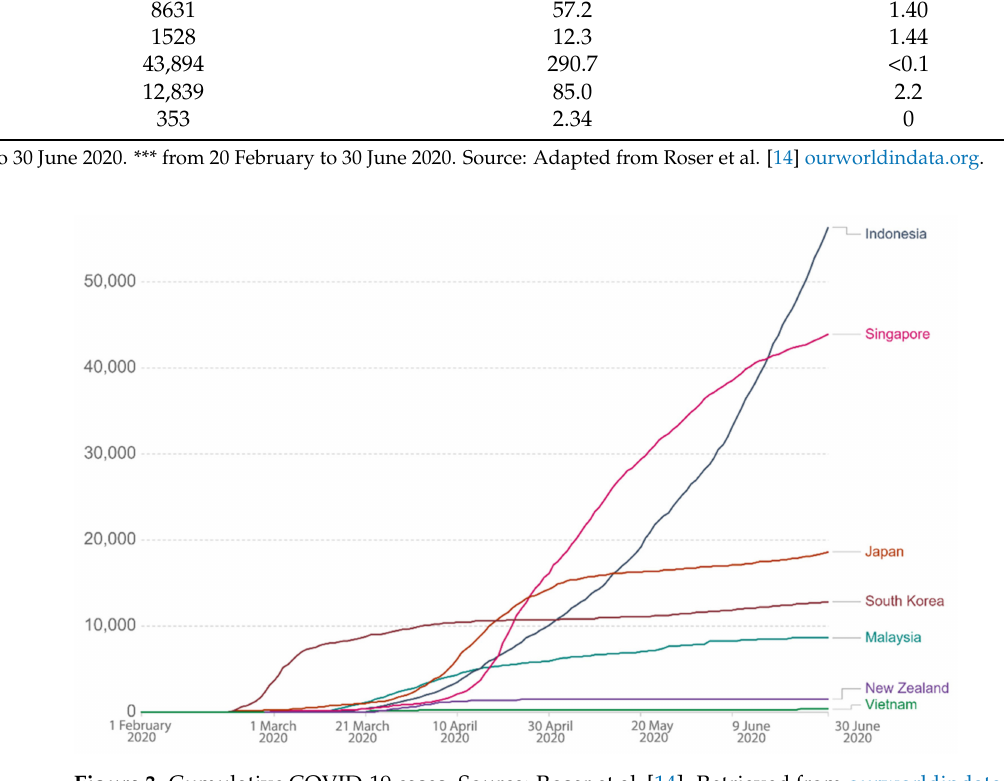
Figure 3. Cumulative COVID-19 cases. Source: Roser et al. [14]. Retrieved from ourworldindata.com.